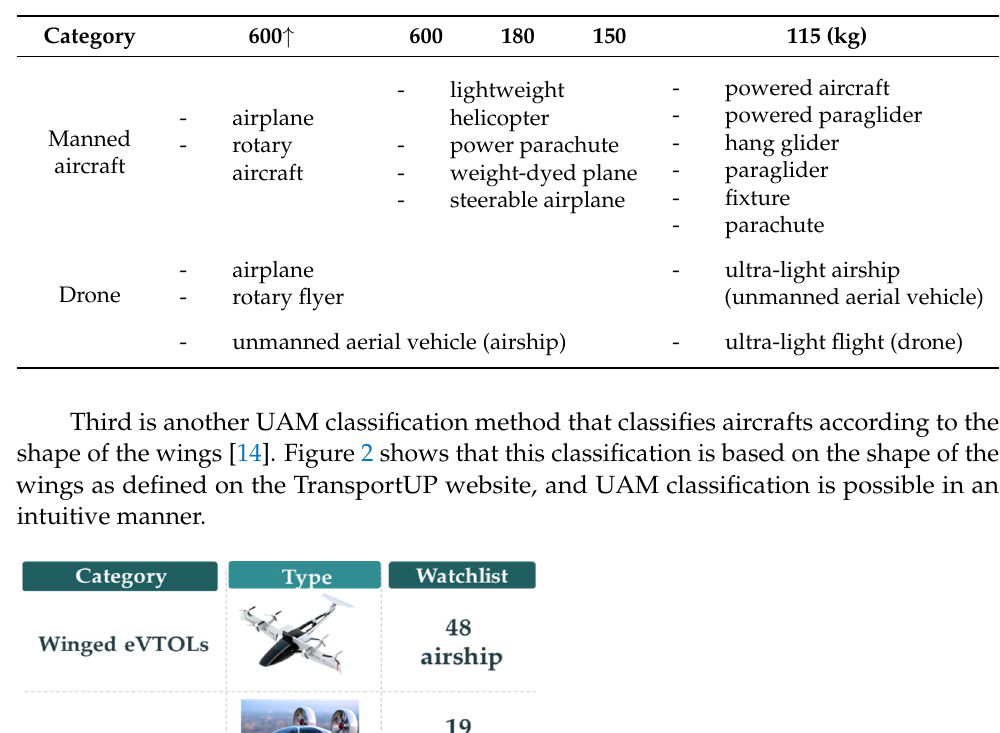
Table 2. UAM classification by weight, KIAST.